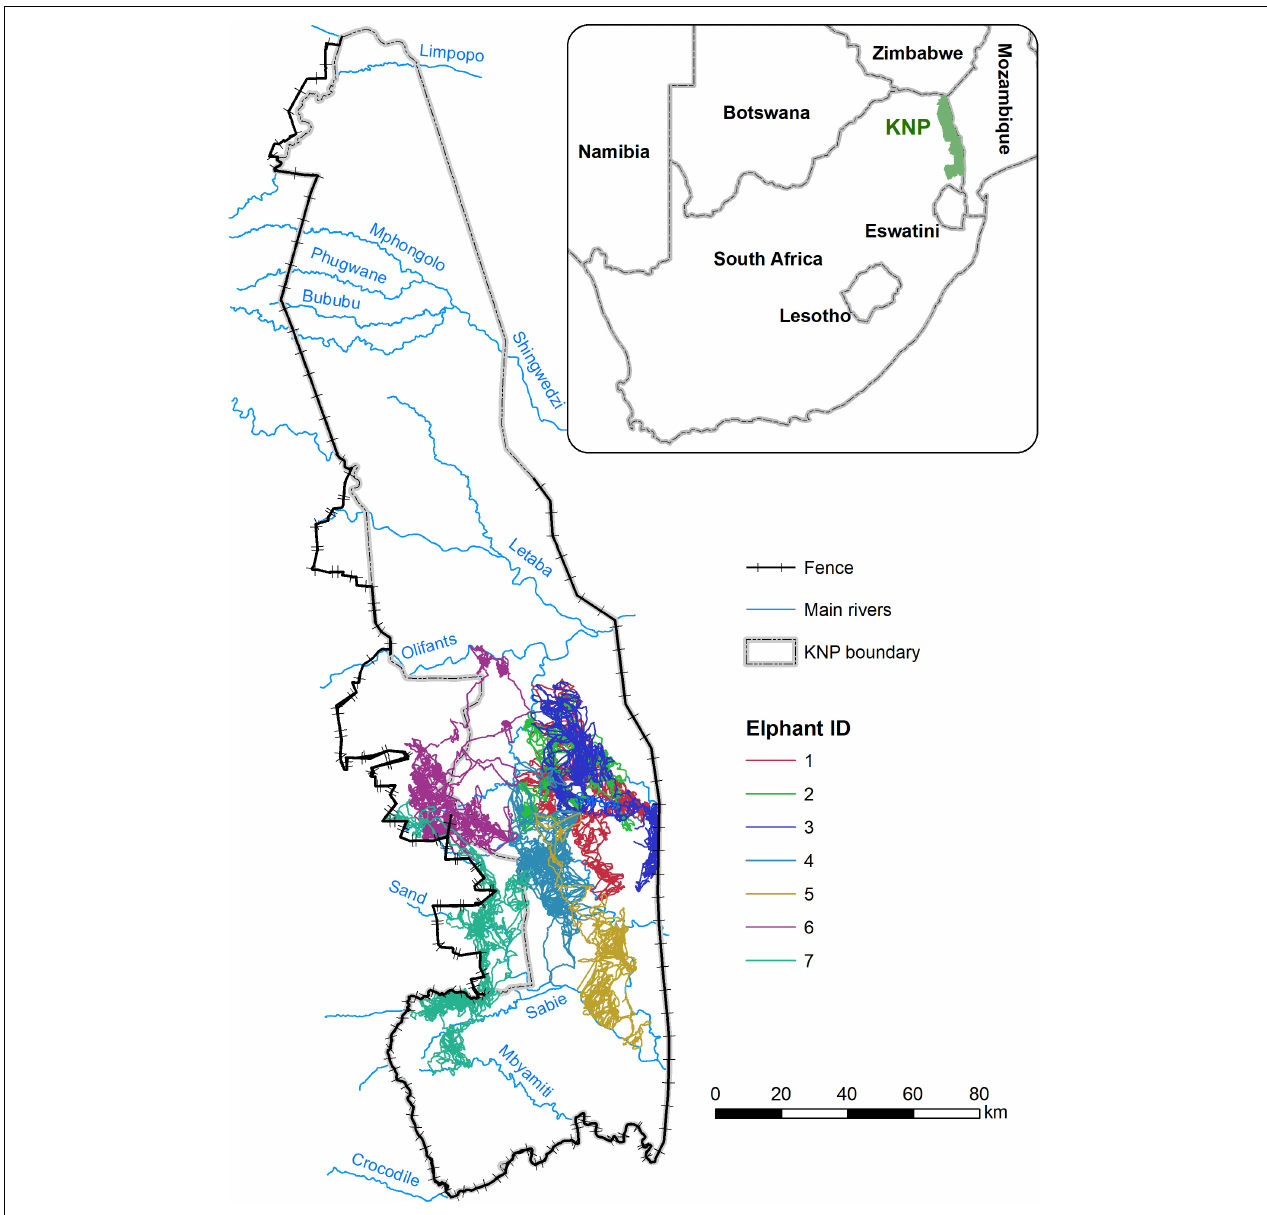
FIGURE 1 | Study area with movement trajectories of seven tracked